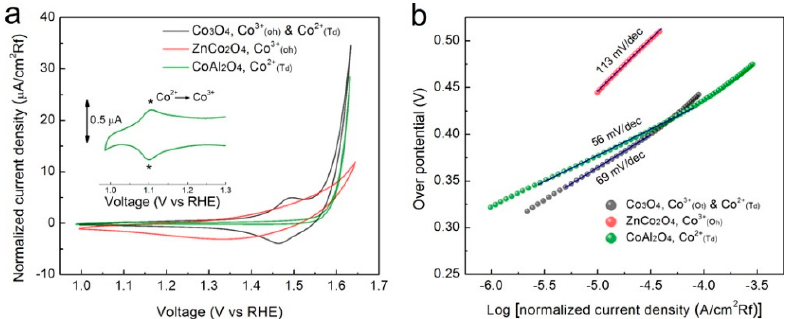
Figure 13. Electrochemical characterization of Co 3 O 4 , ZnCo 2 O 4 , and ZnAl 2 O 4 : ( a ) Normalized cyclic voltammograms and ( b ) corresponding Tafel slopes. Reproduced from [47], with permission from the American Chemical Society, copyright 2016.